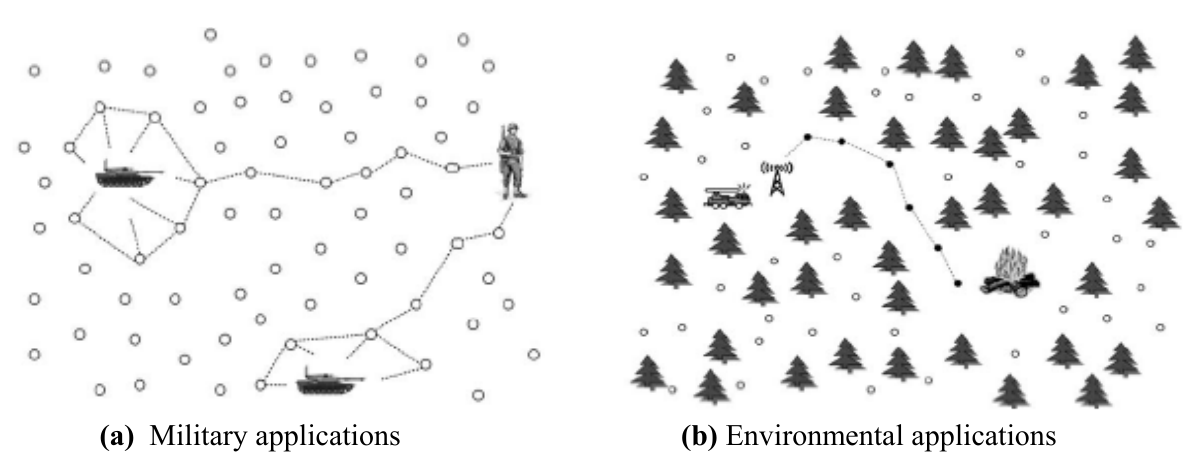
Figure 2. Applications based on WSN